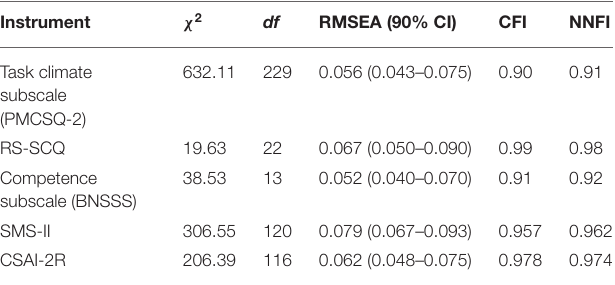
TABLE 2 | Fit indices of the measurement